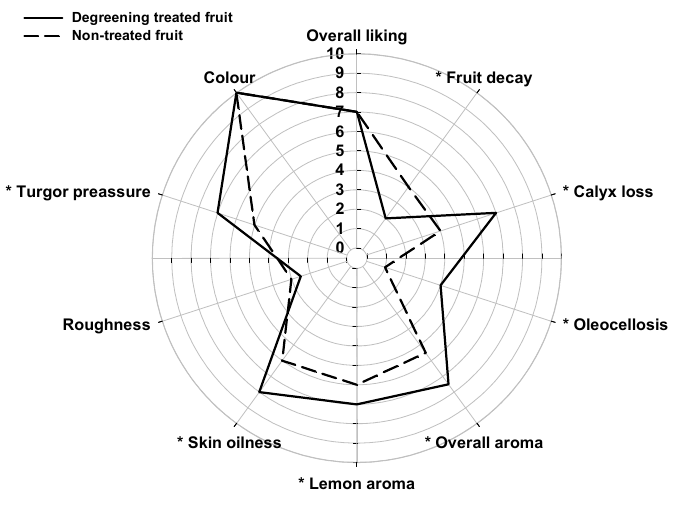
Figure 1. Descriptive sensory analysis of degreening-treated and non-treated lemon fruits in the 2019 experiment. Calyx abscission, turgor, lemon aroma, general aroma, skin oiliness and roughness, colour, oleocellosis and fruit decay were evaluated by trained panellists using a hedonic scale from 0 to 10 points. Asterisks (*) show significant differences between treated and non-treated fruits at p < 0.05 (Tukey’s HSD test).